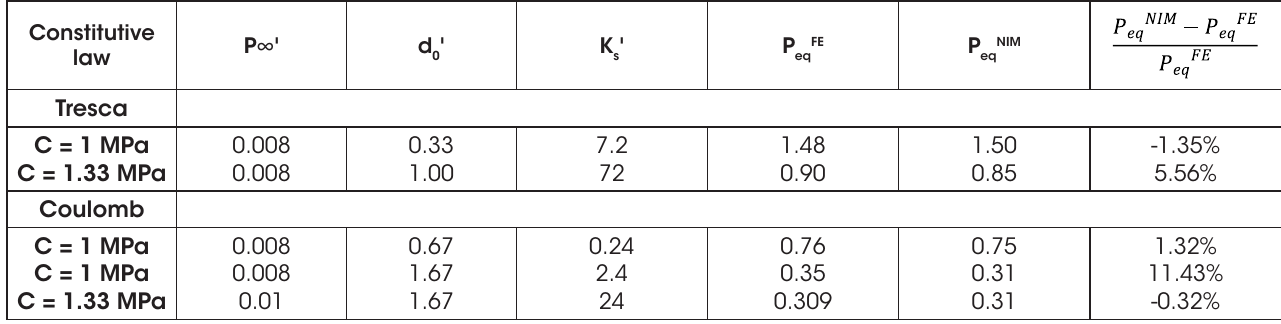
Validity of the method for plastic rockmass Constitutive law